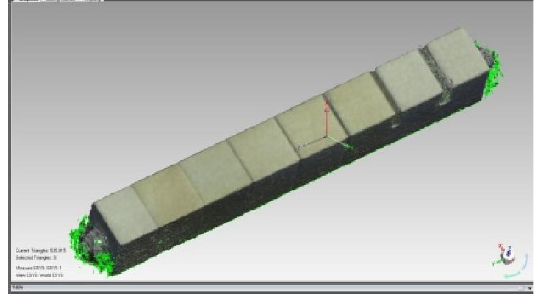
Figure 16. Team 3: Rendering of the gap feature in colour, displaying all